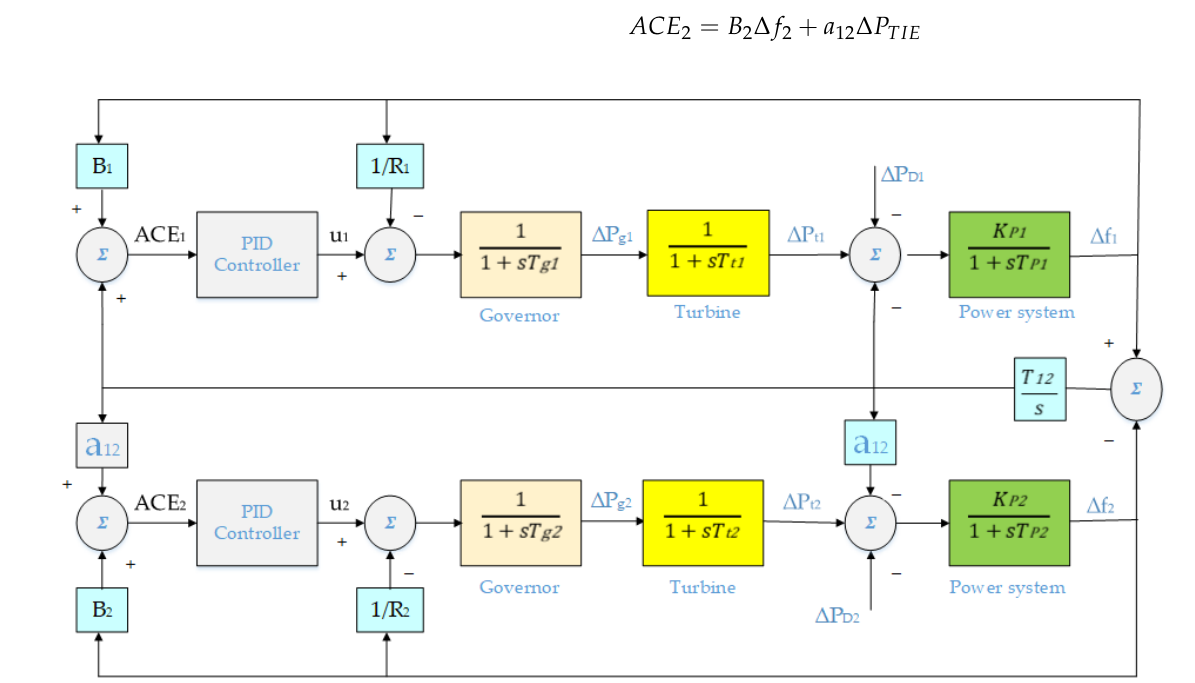
Figure 1. Block diagram for a two-area power system model [15,33].